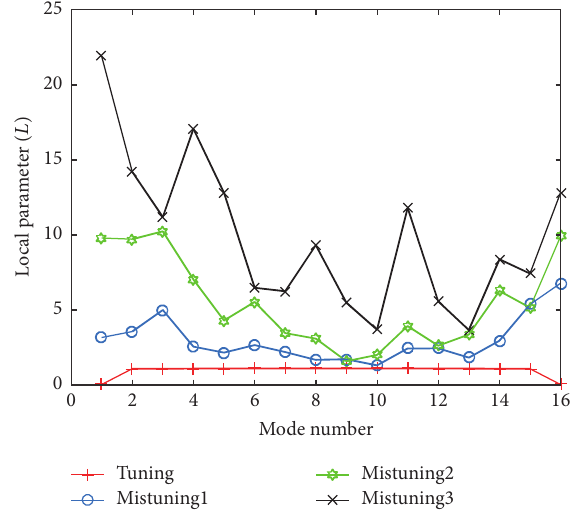
Figure 7: MLPs of MRBs under different mistuned levels.